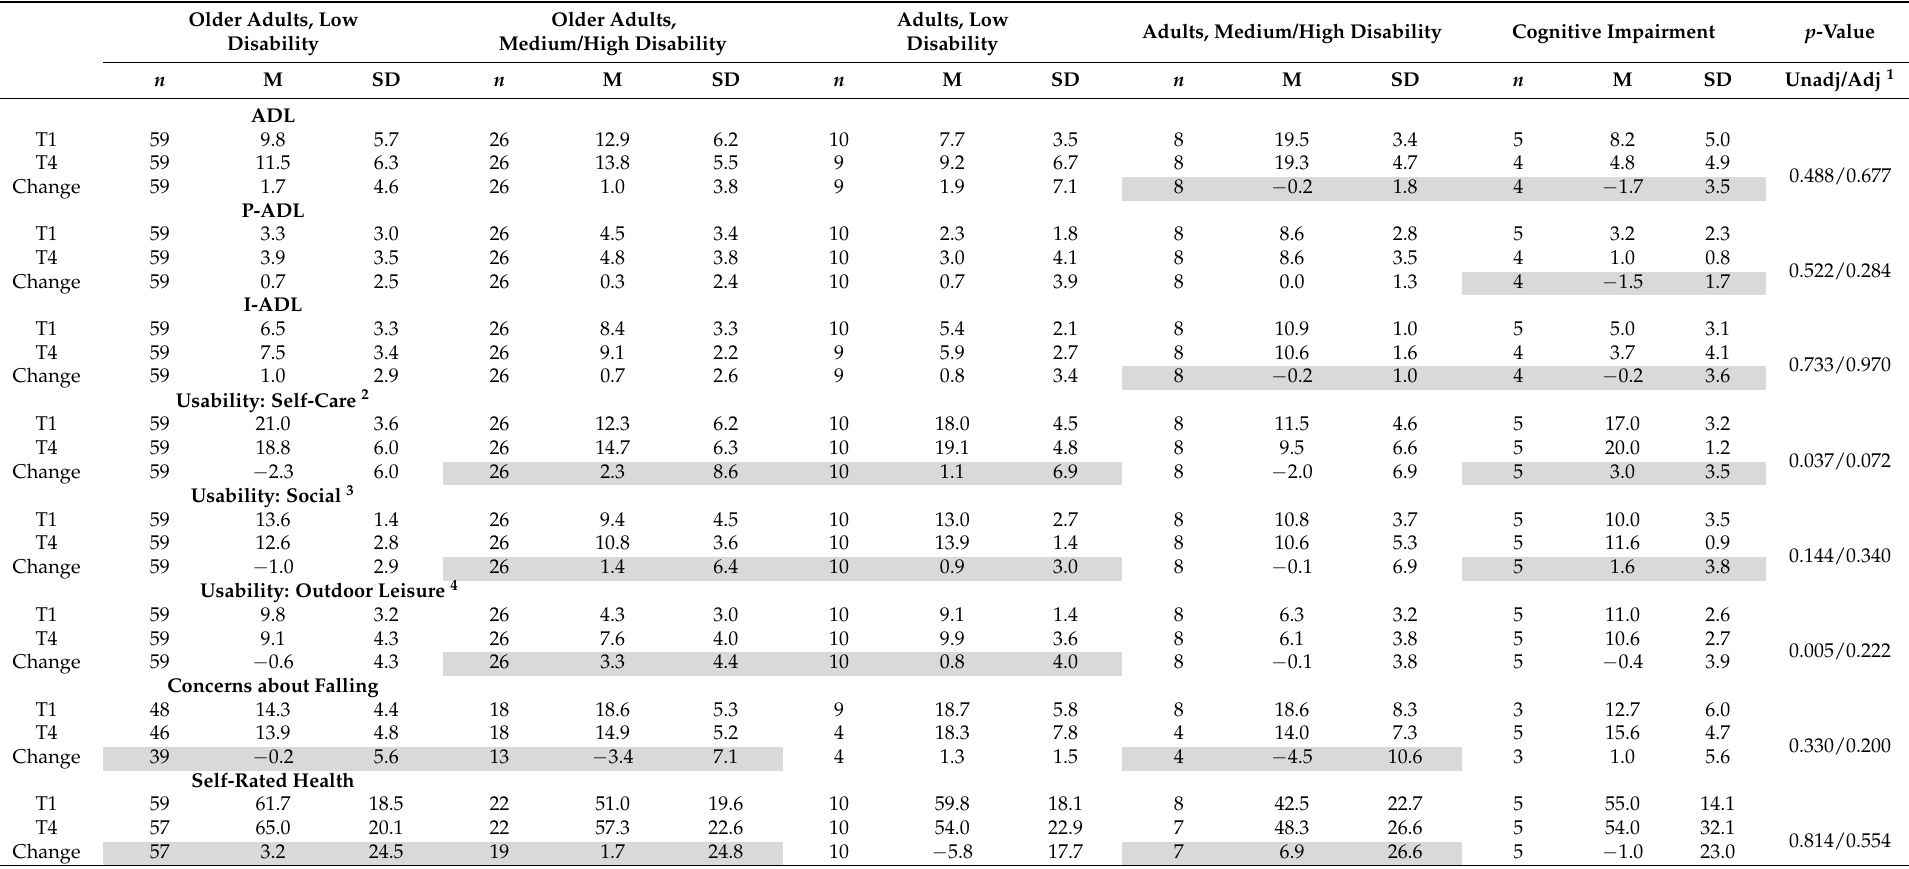
Table 3. Values at T1 and T4, and one-year-change for the five original client profiles with p -values for comparisons of all groups estimated using analysis of variance (ANOVA). Favorable outcomes (i.e., less dependence in ADL, increased usability and self-rated health, and less concerns about falling) are marked with grey shading. Older Adults, Low Older Adults, Adults, Low Adults, Medium/High Disability Cognitive Impairment p Disability Medium/High Disability Disability